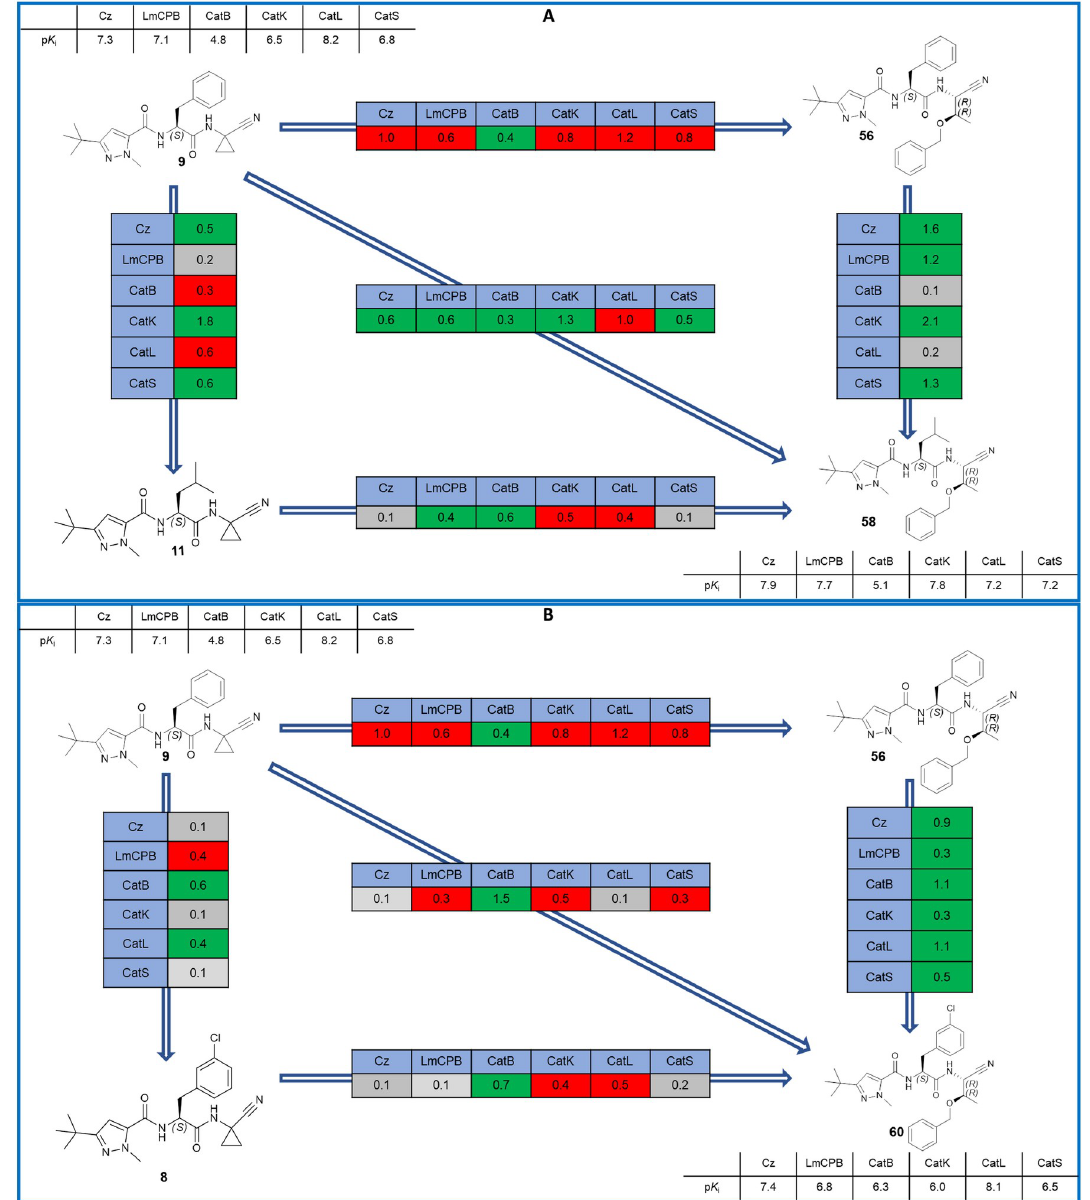
Fig 10. Non-additivity of SAR. Values are reported as differences in p K i and are color-coded as red (negative), green (positive), grey (no significant difference, Δ p K i <